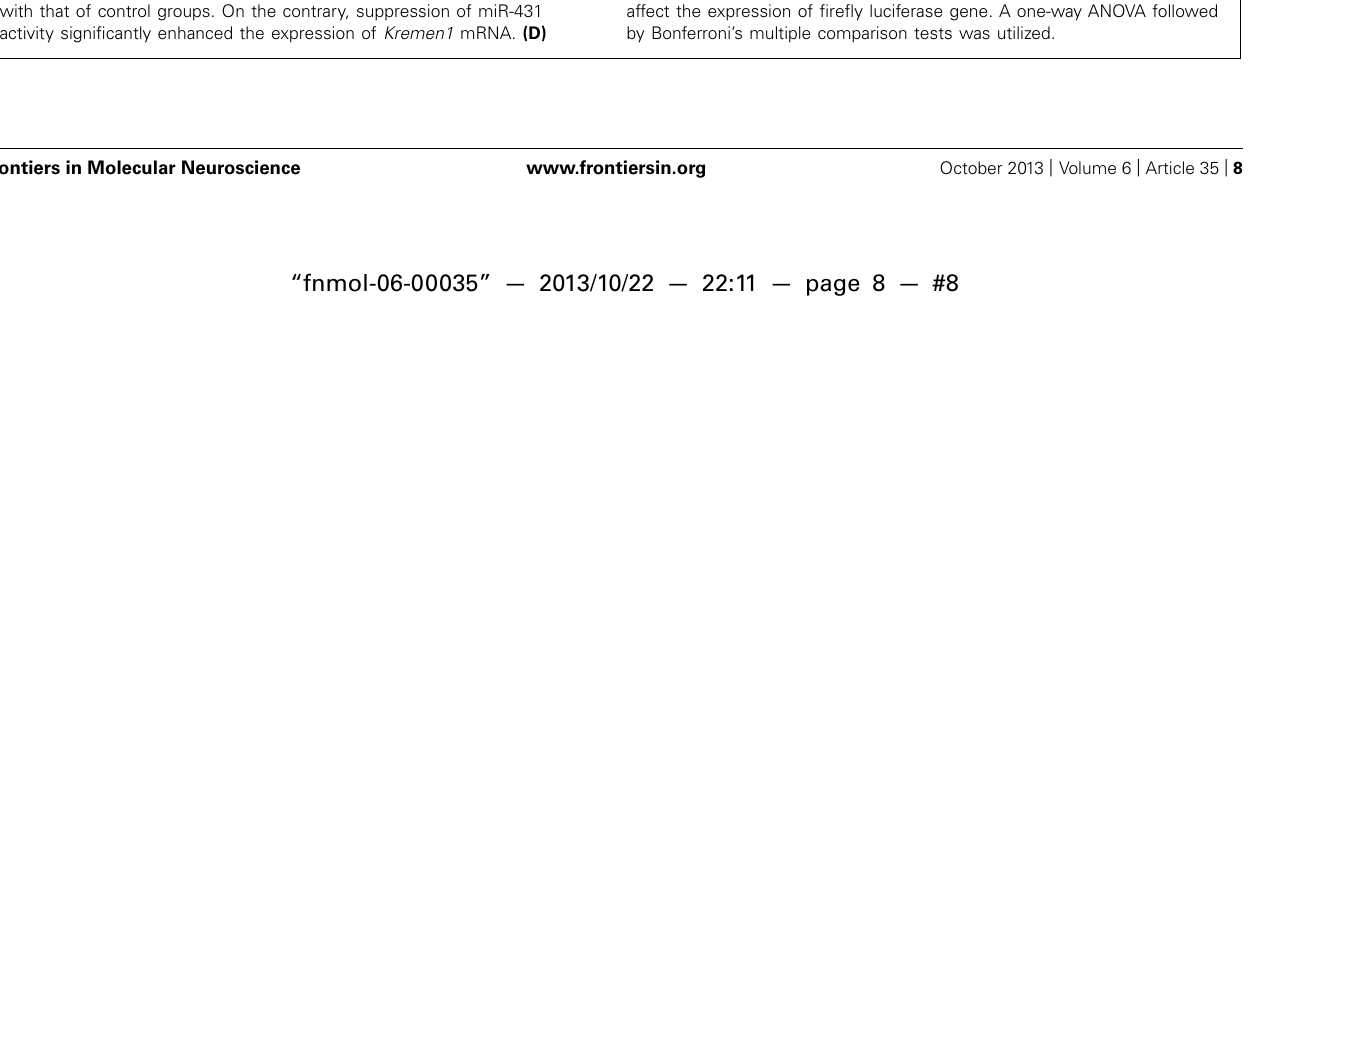
FIGURE 3 | miR-431 regulates Kremen1 expression. (A) RT-qPCR confirmed the increase of miR-431 level in DRG neuron after the transfection of miR-431 mimic. (B) Although overexpression of miR-431 decreased Kremen1 mRNA in total cell lysates (input), it enhanced the binding between Kremen1 mRNA and Ago-2 complex. In the Ago immunoprecipitated fractions, there was an increased amount of Kremen1 mRNA. The lack of signal in the non-specific serum IP sample (IP neg. control) confirmed the specificity of the IP. (C) miR-431 negatively regulated Kremen1 expression at mRNA level. Treatment of miR-431 mimics in DRG neuronal cultures significantly inhibited Kremen1 expression as compared with that of control groups. On the contrary, suppression of miR-431 activity significantly enhanced the expression of Kremen1 mRNA. (D)